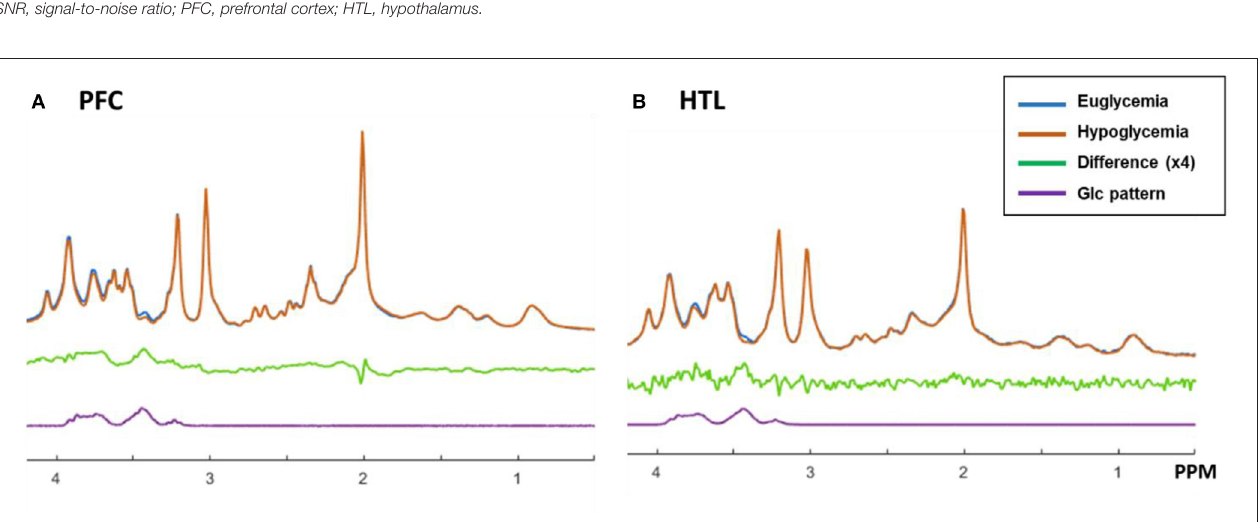
FIGURE 7 | Proton MR spectra of prefrontal cortex (PFC, A ) and hypothalamus (HTL, B ) acquired during euglycemia (blue) and hypoglycemia (orange) and averaged across subjects ( N = 6). The difference between spectra acquired during euglycemia and hypoglycemia is shown in green together with the spectral pattern of glucose in